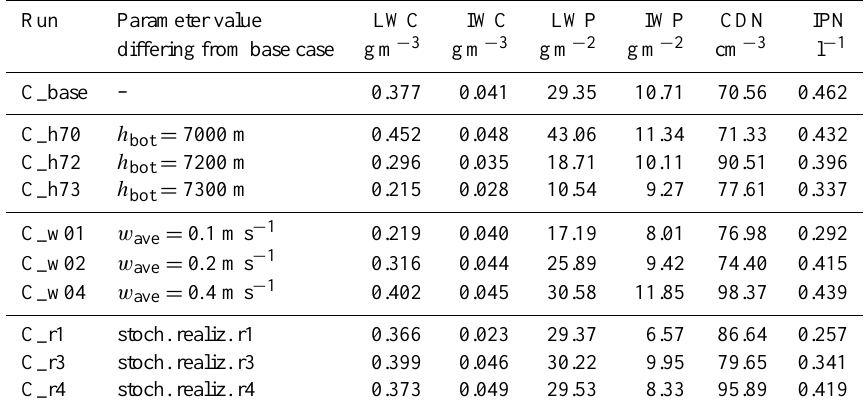
Table 2. Overview of the model results for the dynamic sensitivity runs for the colder case 2 (maximum values of L/IWC: liquid/ice water content; L/IWP: liquid/ice water path; CDN: cloud drop number; IPN: ice particle